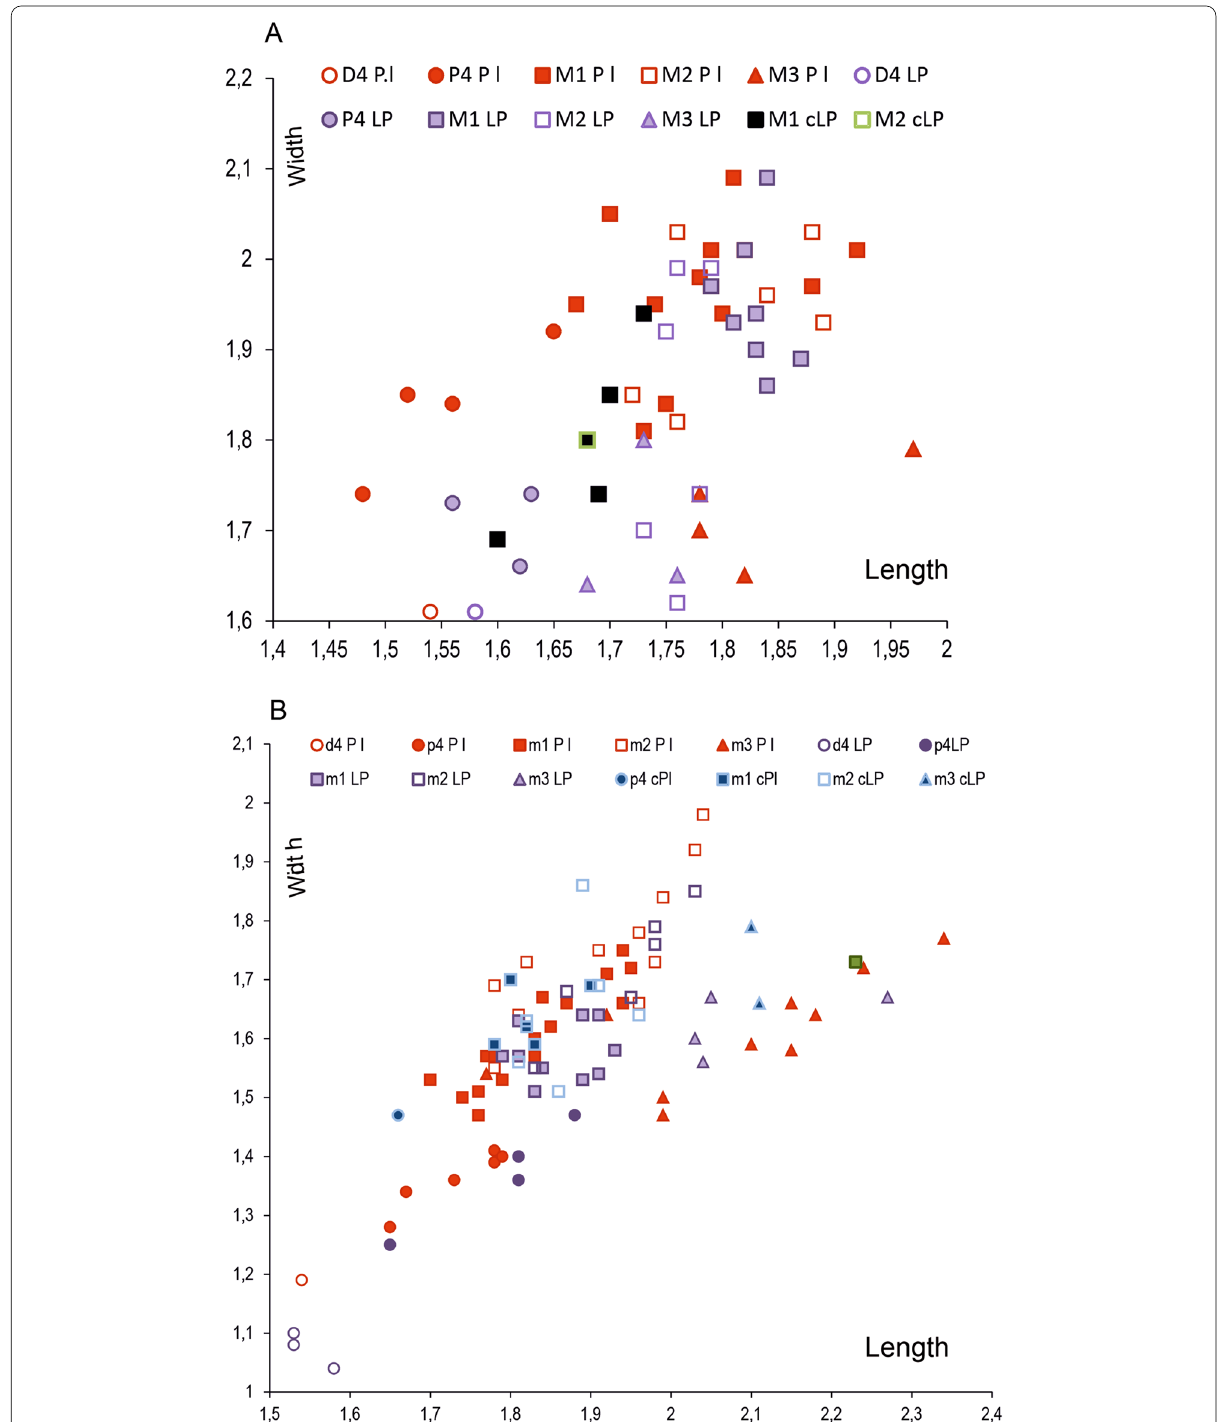
Fig. 21 Bivariate graph of the size (width/length) of the upper (A) and lower (B) teeth of Protadelomys lugdunensis Hartenberger, 1969 from Laprade (Quercy) (LP, light violet marks) compare to the size of the teeth of Protadelomys lugdunensis from Lissieu (Rhône) (PL, red marks). Some teeth from Laprade are Protadelomys cartieri (Stehlin & Schaub, 1951) (cLP. black and green marks on A; blue marks on